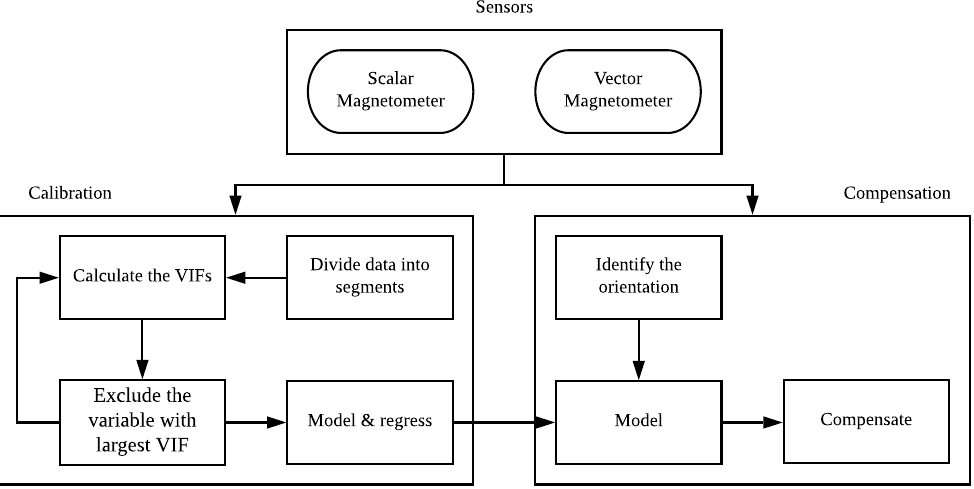
Figure 2. Procedures for calibration and compensation. VIF—variance inflation